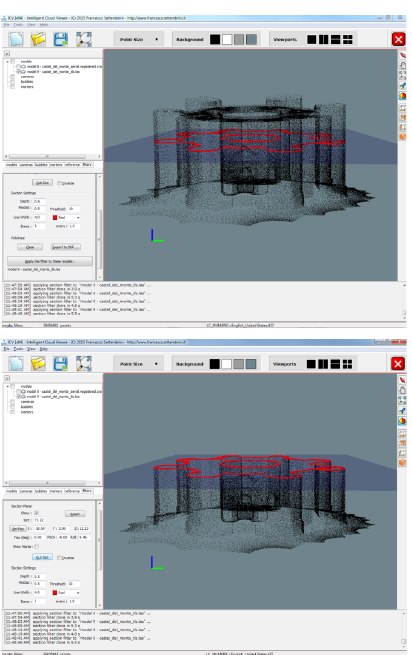
Figure 25. Example of planimetry